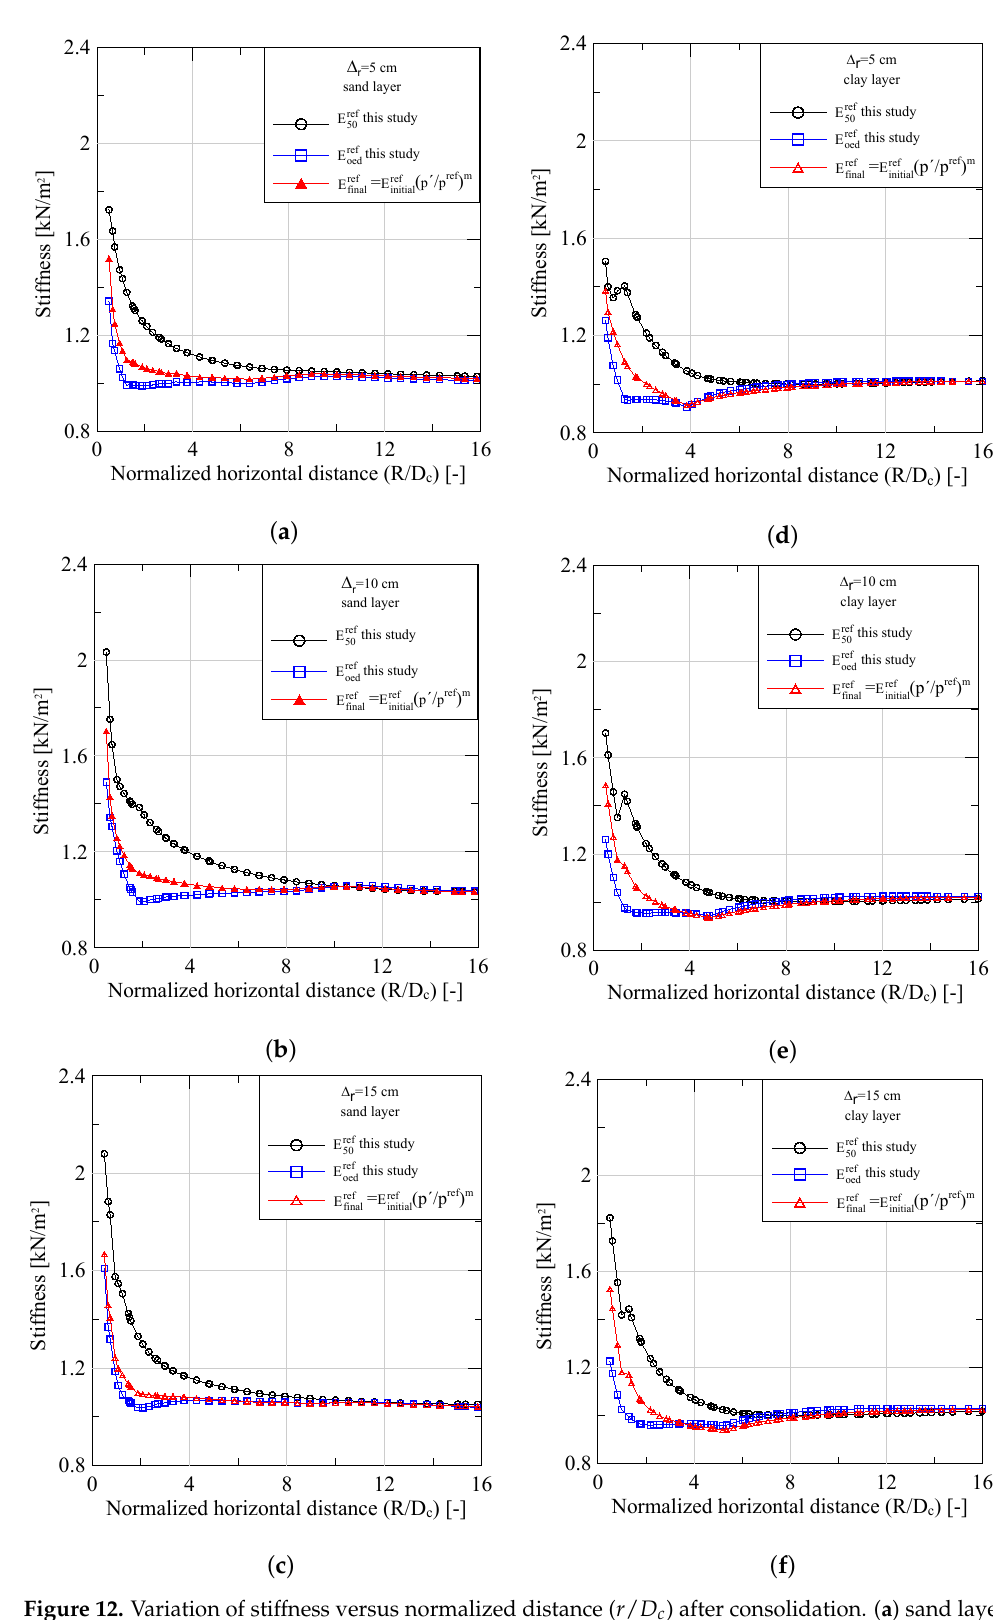
Figure 12. Variation of stiffness versus normalized distance ( r / D c ) after consolidation. ( a ) sand layer ( ∆ r = 5 cm); ( b ) sand layer ( ∆ r = 10 cm); ( c ) sand layer ( ∆ r = 15 cm); ( d ) clay layer ( ∆ r = 5 cm); ( e ) clay layer ( ∆ r = 10 cm); ( f ) clay layer ( ∆ r = 15